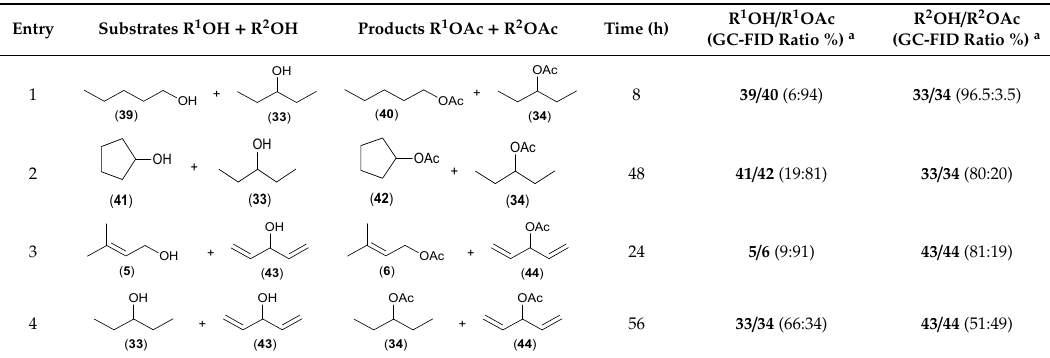
Figure 1. Time-dependent evolution of the ratio between forming acetates during competitive experiments (cf. Scheme 3, cf. Tables S3–S6 in the Supporting Information).